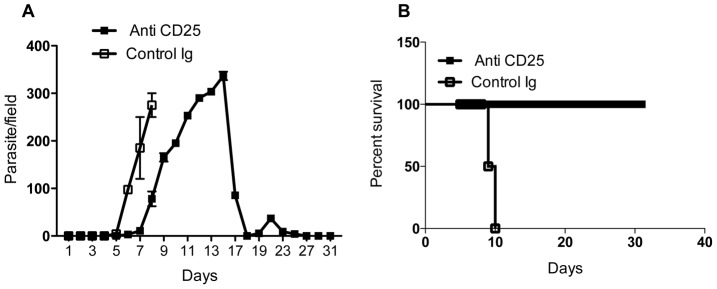
The effect of anti-CD25 mAb treatment in infected BALB/c mice is dependent on infection route.BALB/c mice were injected intraperitoneally with 100 µg of anti-CD25 mAb (PC61) or control Ig. After 24 hr, mice were infected with 103
T. congolense clone TC13 in the footpad and parasitemia (A) and survival period (B) were determined until the experiment was discontinued. Results presented are representative of 2 independent experiments (n = 4–6 mice per group) with similar results.